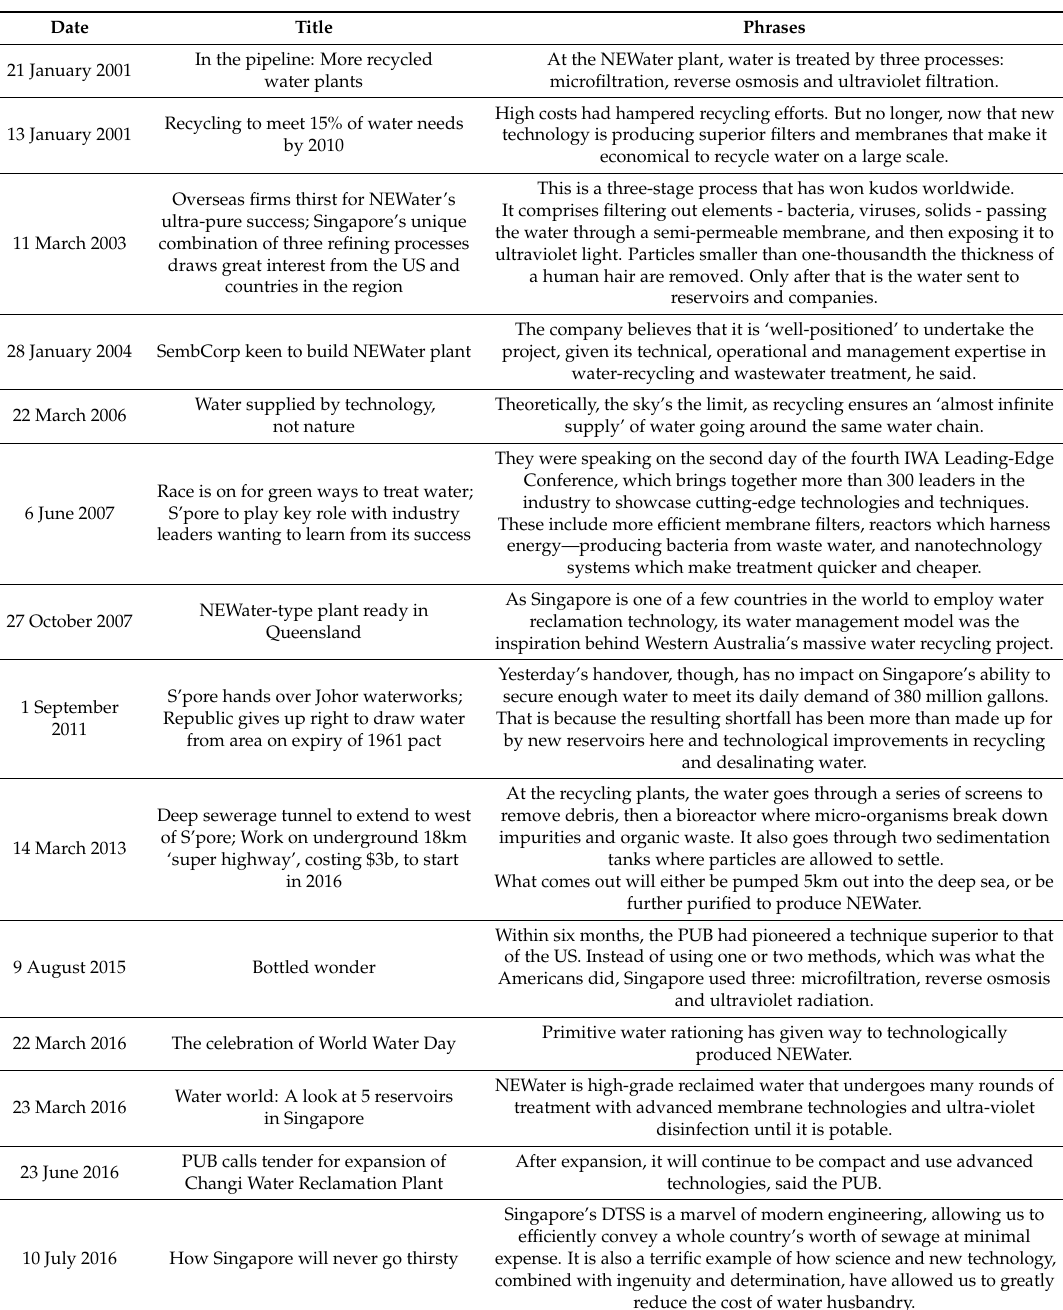
Table 1. Excerpts of newspaper articles from The Straits